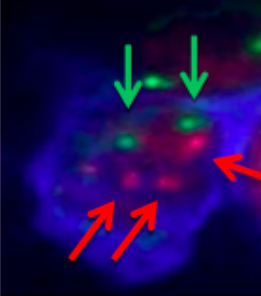
Figure 3. Cytogenetic aberrations of cPC. ( A ) Classical (medullary/osseous) MM vs. MM-EMD vs. pEMP/SOP. ( B ) Classical MM vs . SOP or MM-EMD/pEMP paraskeletal vs. MM-EMD/pEMP not paraskeletal. Shown are percentages of patients with a distinct cytogenetic aberration (from evaluated patients). ( C ) Representative cIg-FISH study showing C-MYC amplification in a patient with MM-EMD (skin infiltration). Amplified signals for C-MYC (red arrows) and two signals for p7t1 (centromere 7, green arrows) are demonstrated. Blue color stains intracytoplasmic light chains.